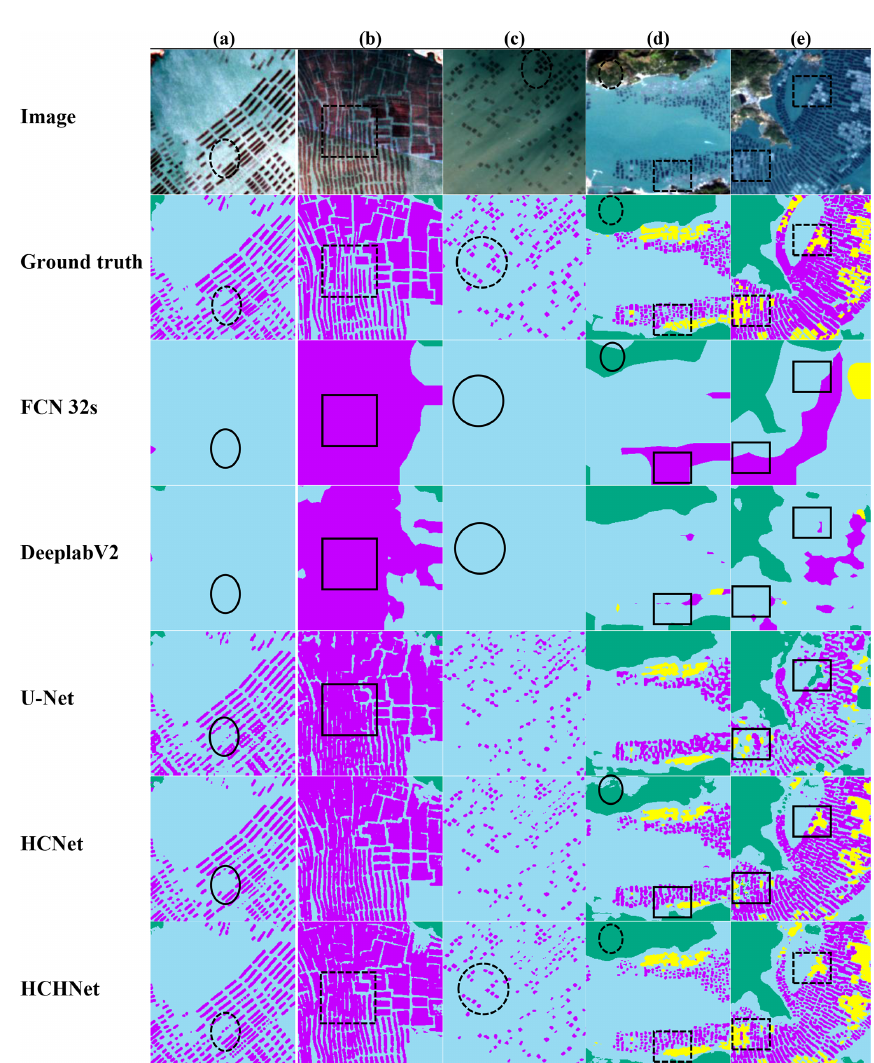
Figure 7. The classification results of MPC and MAC areas comparing the proposed HCHNet method with other approaches. The black solid outlined areas indicate where HCHNet obtains better results. The dotted line shows same locations in other images. The purple, yellow, blue, and green areas in the classification maps represent the MPC, MAC, sea, and land areas, respectively.